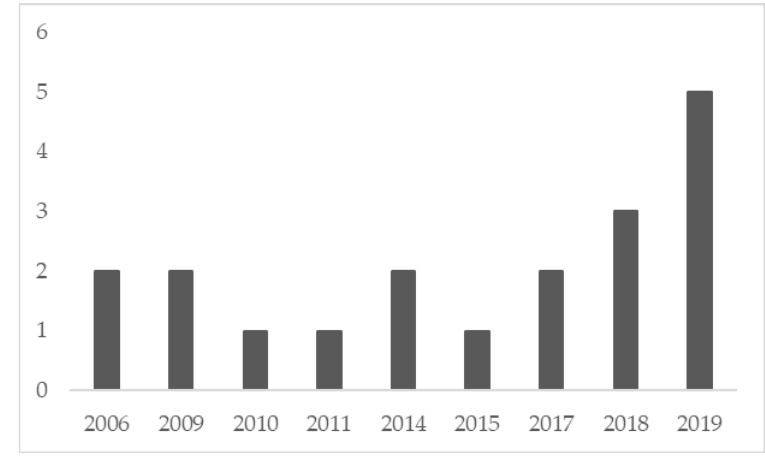
Figure 2. Number of publications per year.